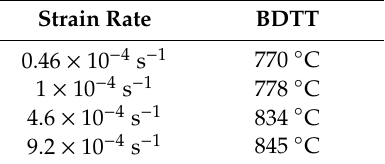
Table 3. BDTT of Ti-48Al-2Nb-0.7Cr-0.3Si Alloy at Di ff erent Strain Rates.